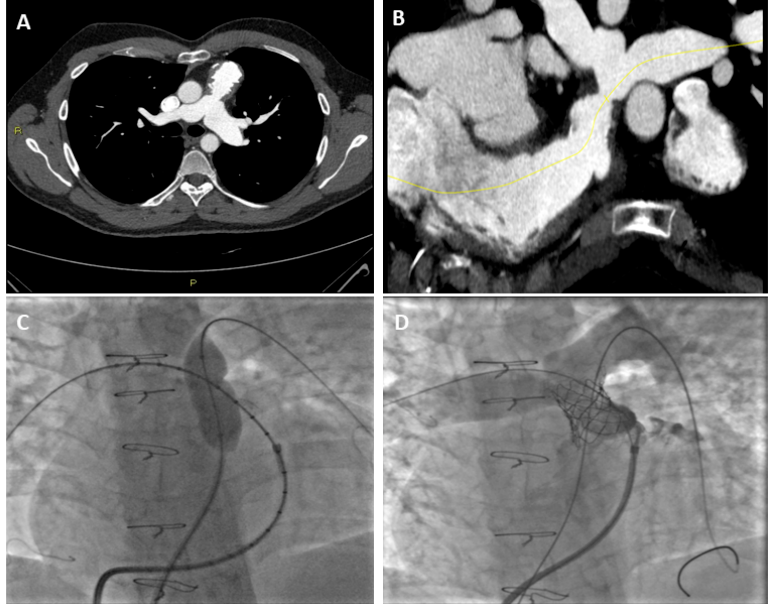
Figure 3. Assessment of Pulmonary Stenosis with CCT in a 15-year-old male patient: ( A ) Axial CT image with stenosis of the common trunk of the pulmonary artery; ( B ) CT reconstruction of the vessel using a dedicated post-processing software; ( C ) Angiographic image of percutaneous transluminal angioplasty (PTA) of the stenotic tract and ( D ) Angiographic image showing correct stent placement after PTA.